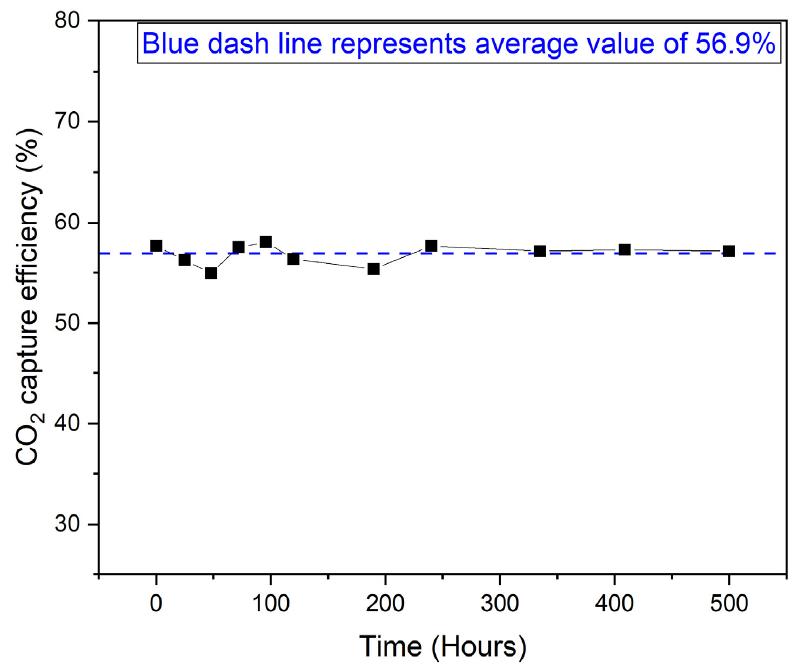
Figure 8. Continuous solvent flow longevity test of surface-only covalent 3-D aggregate immobilized enzyme packing.